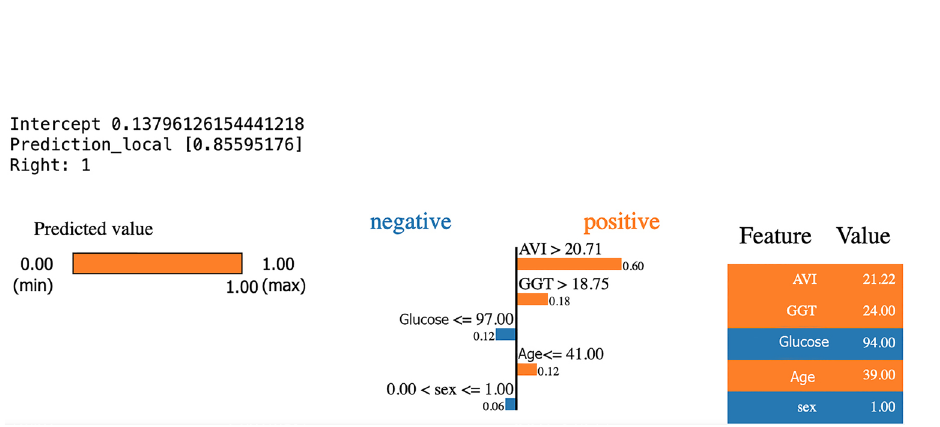
Figure 9. Application of LIME for diagnosis of sick subject during the